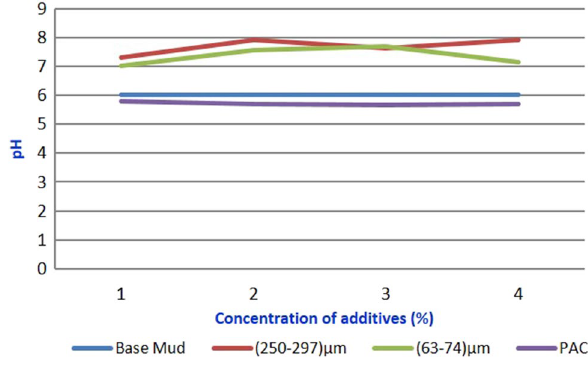
Fig. 11 pH trend of the developed drilling fluid formulations with increasing concentration of the